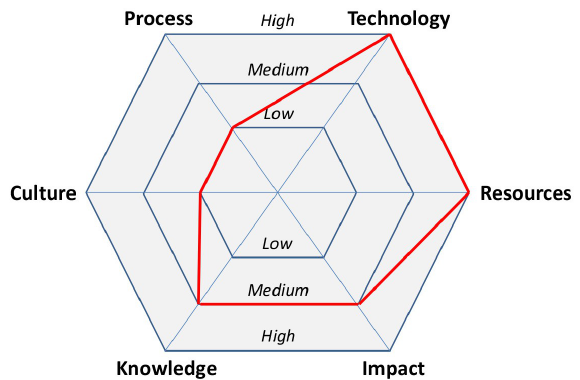
Figure 4. Application of health check tool to project from case study